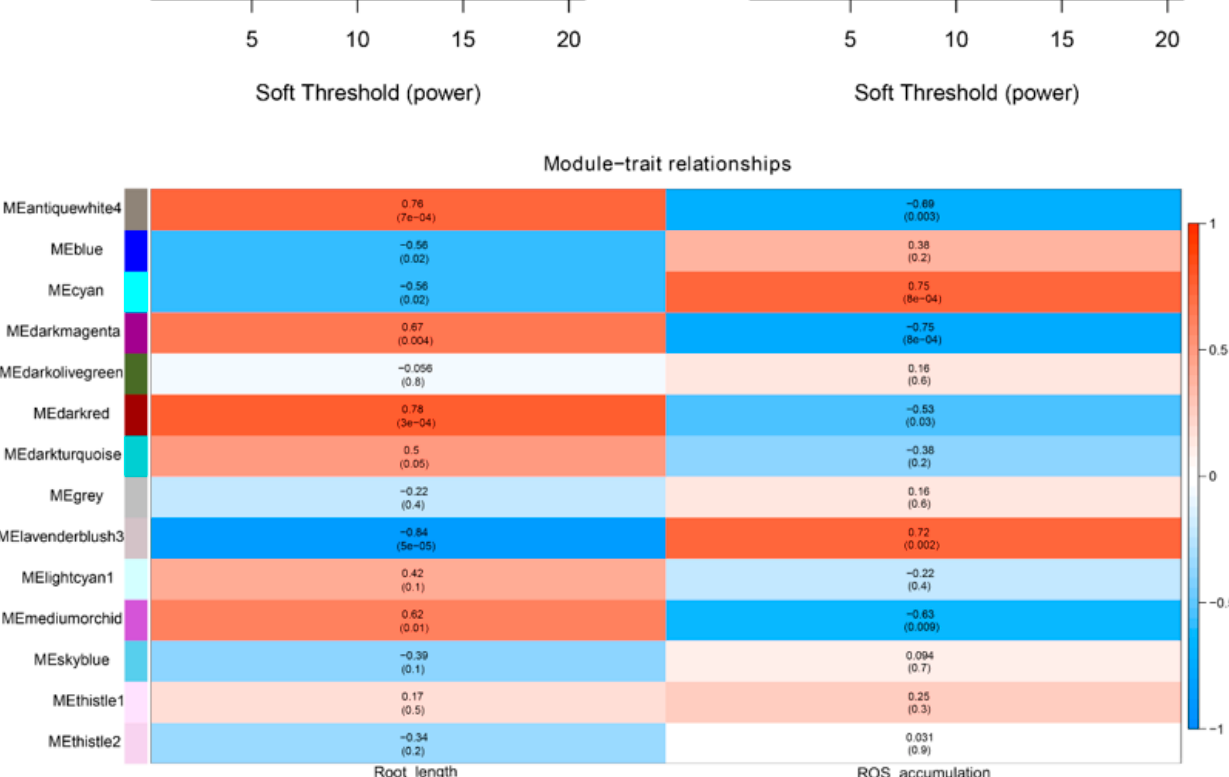
Figure 9. WGCNA of wheat genes identified in CS and QM in response to salt stress. ( a ) Scale independence and mean connectivity curves. Horizontal axis on left and right figures indicates power value, and vertical axis represents a fitting degree of adjacency matrix to a scale-free network. Vertical axis on right figure represents average connectivity of each node in the network. ( b ) Module- trait relationships showing significance of module eigengene correlation with traits (root length and ROS accumulation). Left panel shows 14 modules. Module-trait correlation ranging from − 1 (blue) to 1 (red) is indicated with color scale on right.